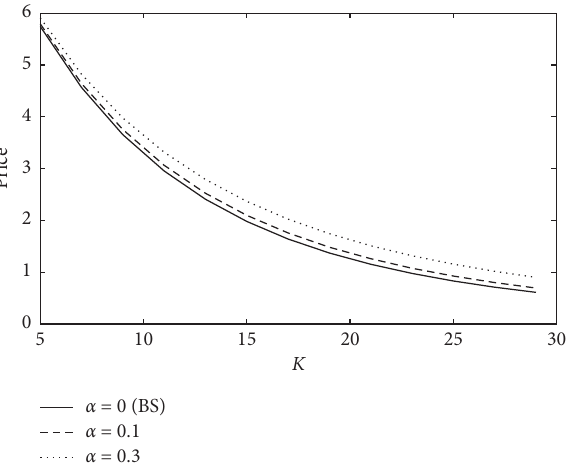
Figure 4: Comparison between the real call option prices with the one obtained by different models under different strike prices K . Here, BS price stands for the price obtained by the classical Black–Scholes model, and α -BS stands for the price obtained by formula (26) with α � 0 . 1.